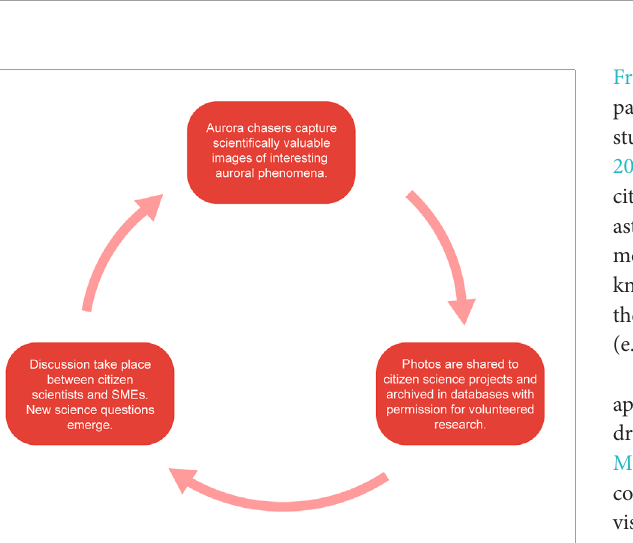
FIGURE 2 An example of how information flows through aurora chasing communities. Subject matter experts (SMEs) and citizen scientists collaborate to identify scientific interests which can benefit from aurora chasers’